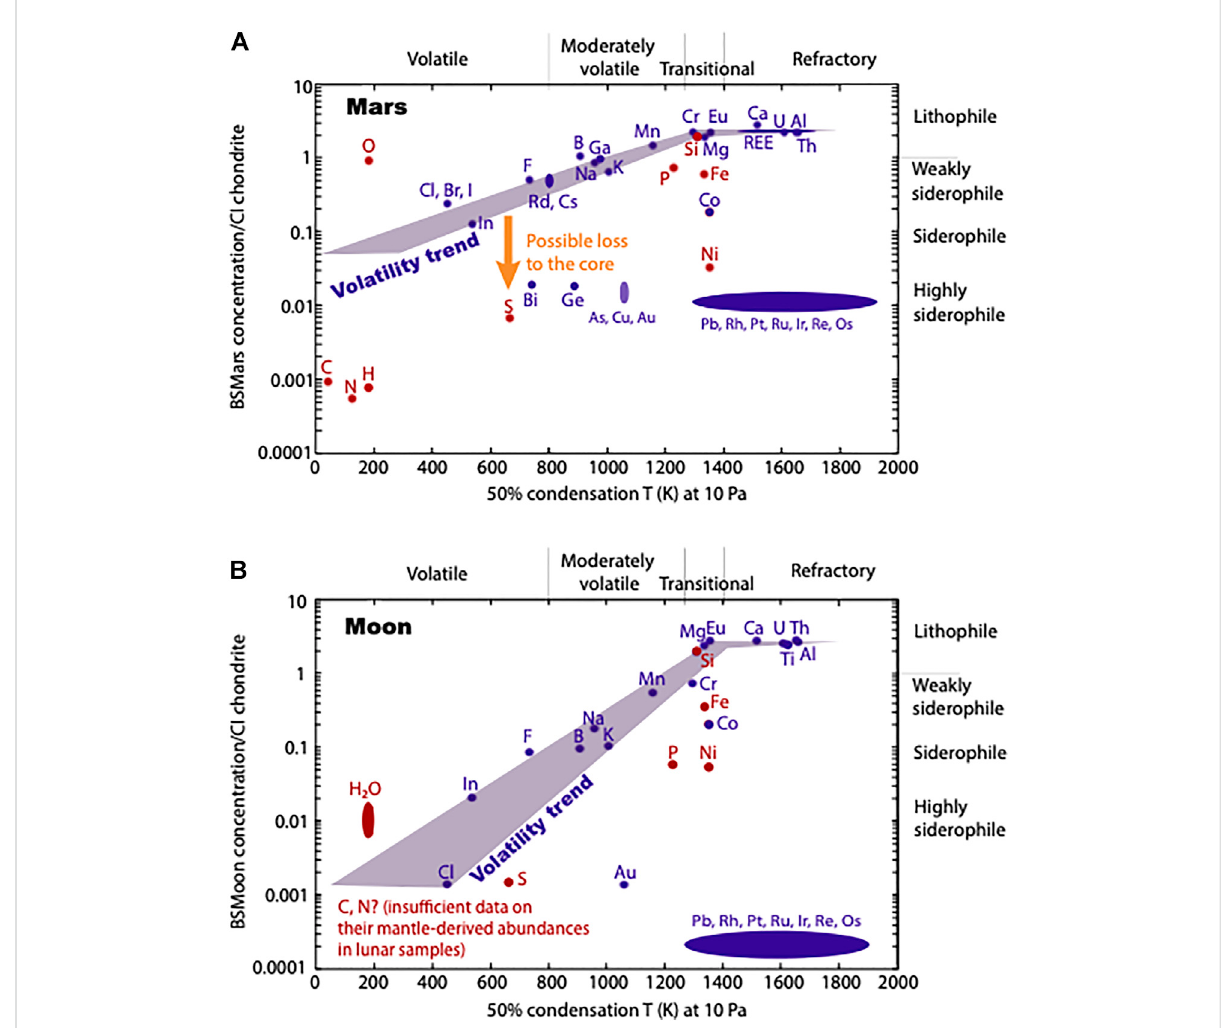
FIGURE 9 Volatility trends for Mars (A) and the Moon (B) showing the concentration of elements in bulk silicate Mars (BSMars) and bulk silicate Moon (BSMoon) relative to CI chondrite. Data for Mars are from Yoshizaki and McDonough, 2020, and data for the Moon are from Hauri et al., 2015. 50% condensation T values at 10 GPa are from Lodders,